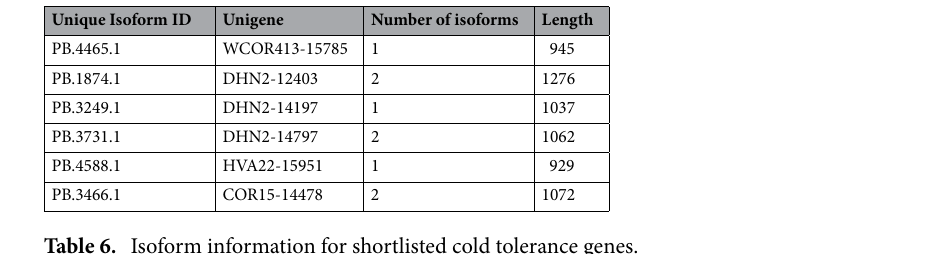
Table 6. Isoform information for shortlisted cold tolerance